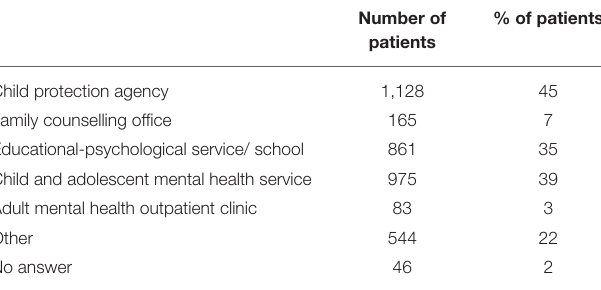
TABLE 5 | Prevalence of outpatients ( N = 2,488) where children are reported to be followed up by various services or agencies for